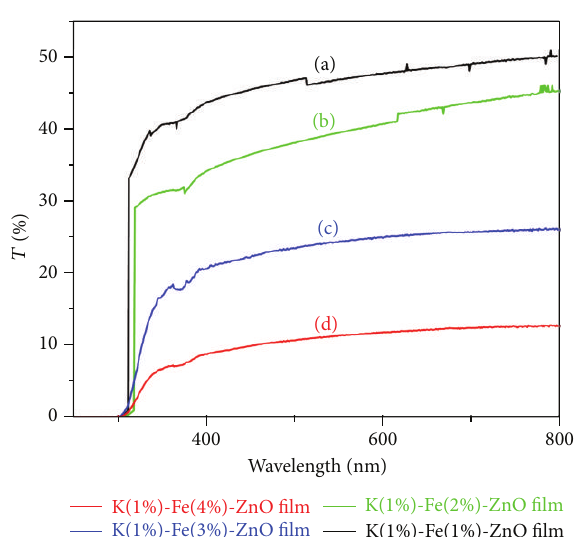
Figure 5: UV transmittance of (K (1%), Fe) codoped ZnO for Fe concentrations: (a) 1%, (b) 2%, (c) 3%, and (d) 4%.